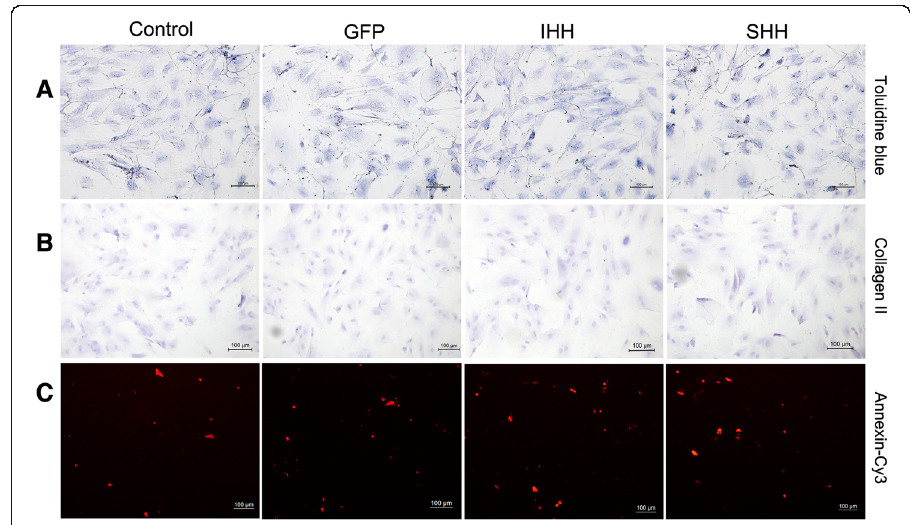
Fig. 6 Staining results for the process of differentiation induction in the 2D environment. ( a ) Toluidine blue staining; ( b ) Collagen II immunohistochemical staining; ( c ) Annexin V-Cy3 immunofluorescence staining. (Bar = 100